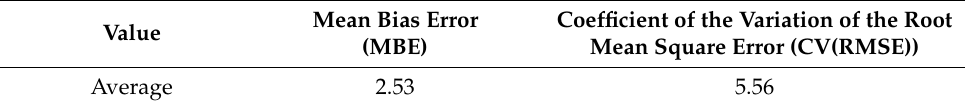
Table 6. Average zone value for MBE and